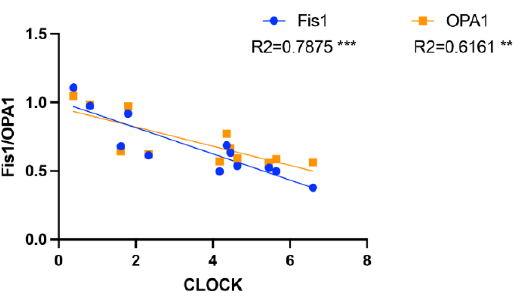
Figure 6. The CLOCK expression is negatively correlated with Fis1 and OPA1 expression. ** p < 0.01 and *** p < 0.001.